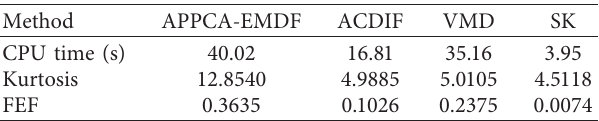
Table 8: The comparison results of APPCA-EMDF, ACDIF, VMD, and SK methods in experimental case